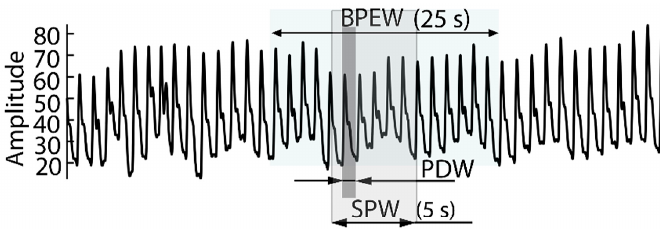
Figure 4. PPG with signal preprocessing window (SPW), blood pressure estimation window (BPEW) and peak detection window